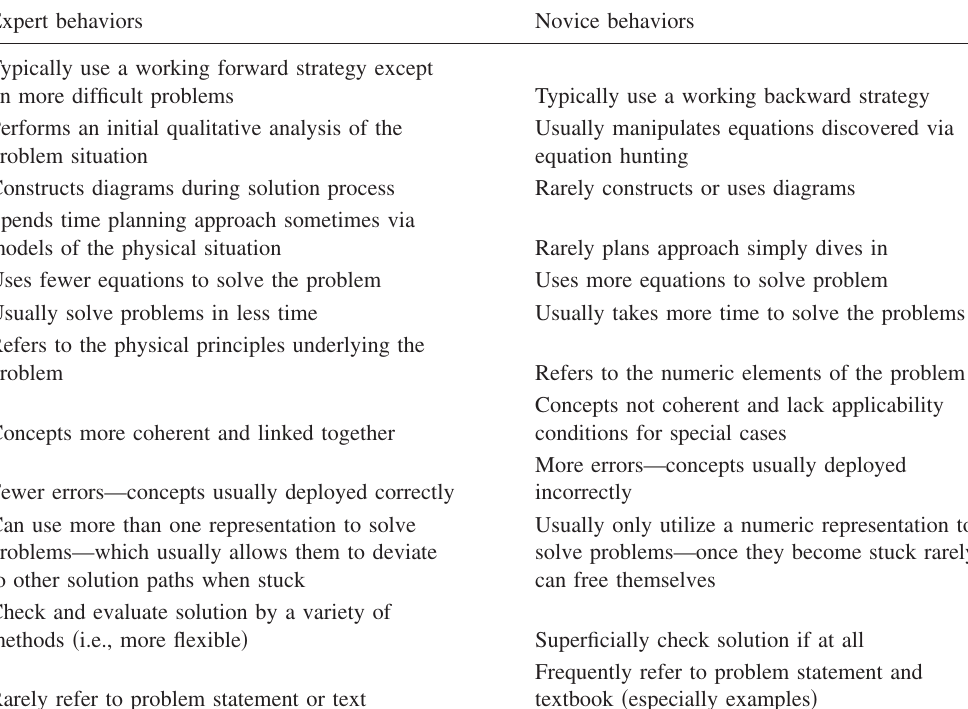
TABLE IV. Comparison of expert and novice problem-solving strategies. Expert